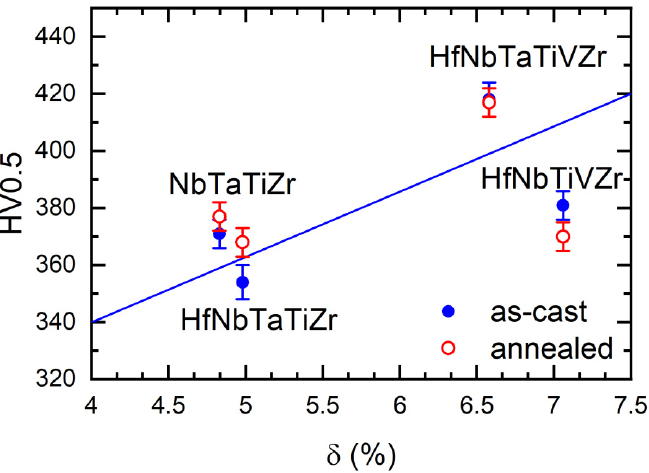
Figure 21. Microhardness of NbTaTiZr, HfNbTaTiZr, HfNbTiVZr, and HfNbTaTiVZr alloys plotted as a function of the atomic misfit parameter δ ; full symbols—as-cast alloys; open symbols—annealed alloys.